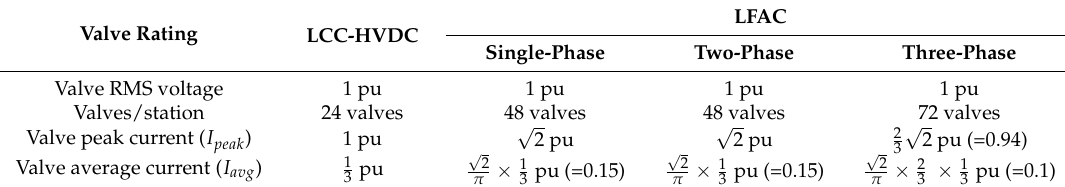
Table 2. Comparison of valve rating.